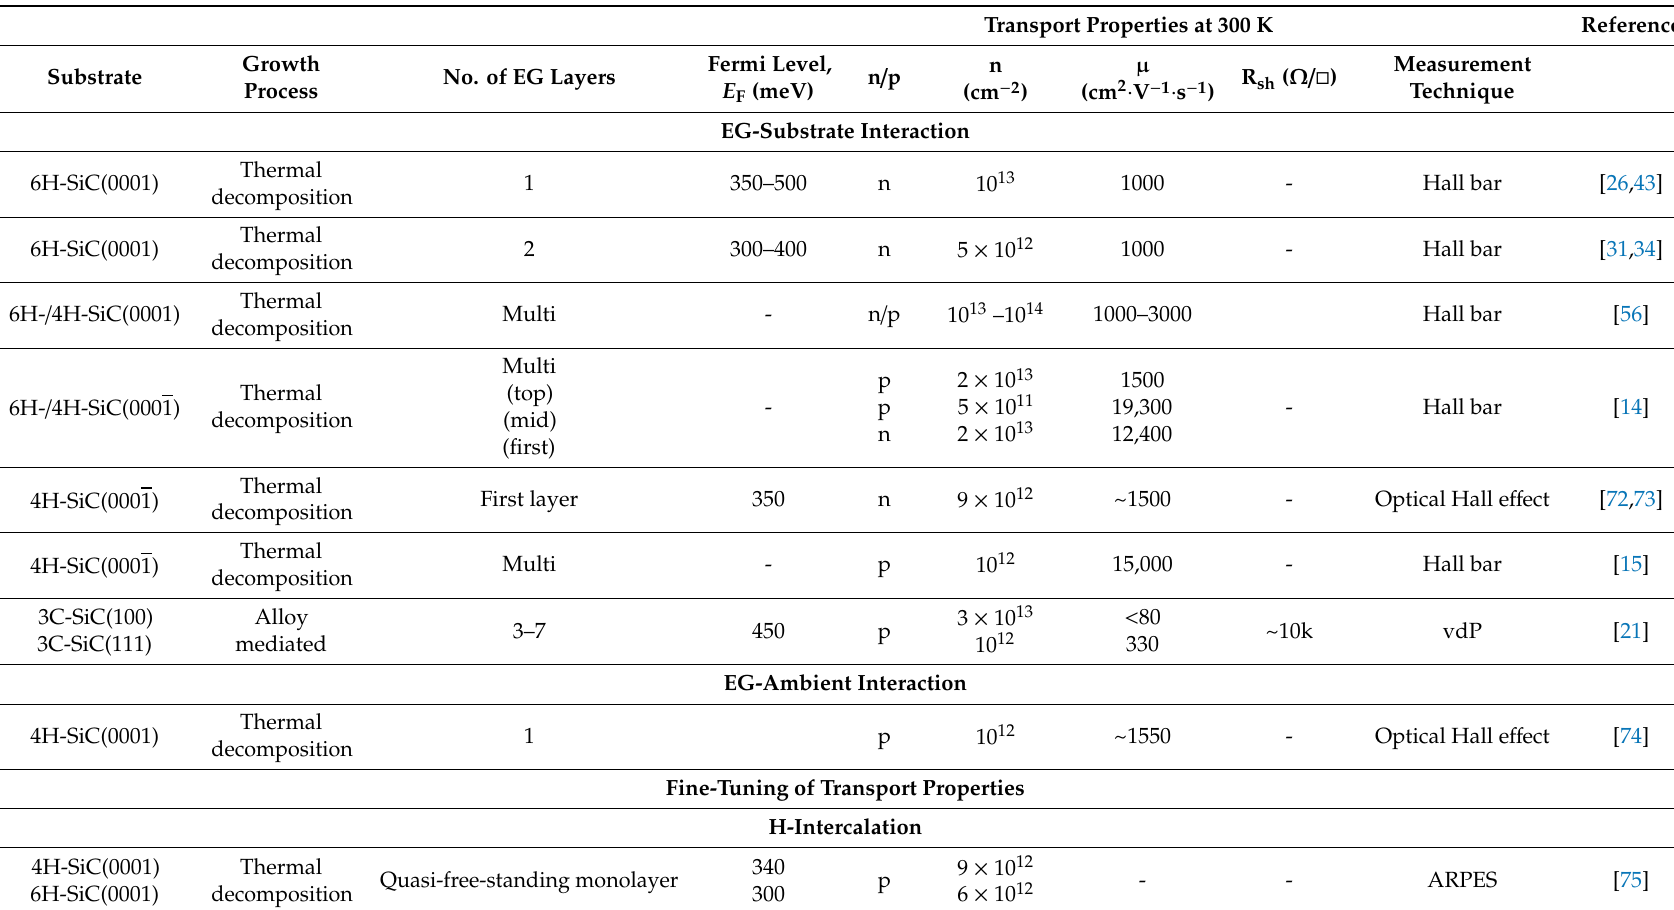
Table 1. Summary of electronic and transport properties of as-grown epitaxial graphene on SiC(0001), SiC(0001), and 3C-SiC / Si substrates indicating the e ff ect of substrate and ambient and fine-tuning of properties using intercalation, functionalization, and gate